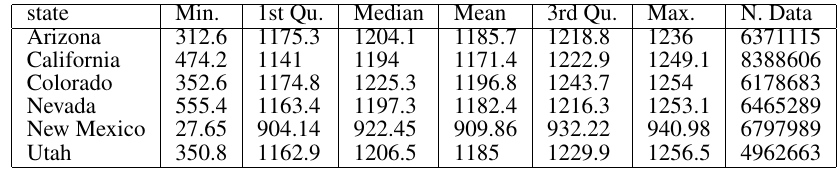
Table 2. Solar Duration Radiation in summer.